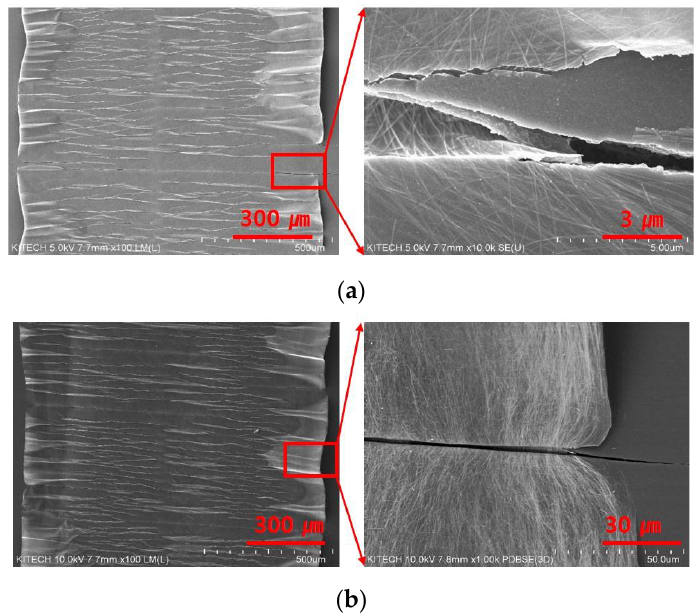
Figure 3. FESEM plan view images of Ag NWs printed on the 40% pre-stretched silicone rubber film: ( a ) 0% strain, ( b ) 10% strain.